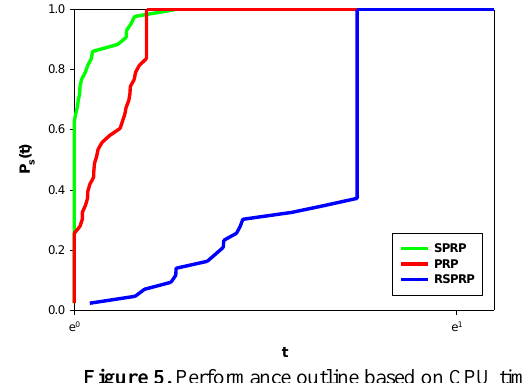
Figure 5. Performance outline based on CPU time